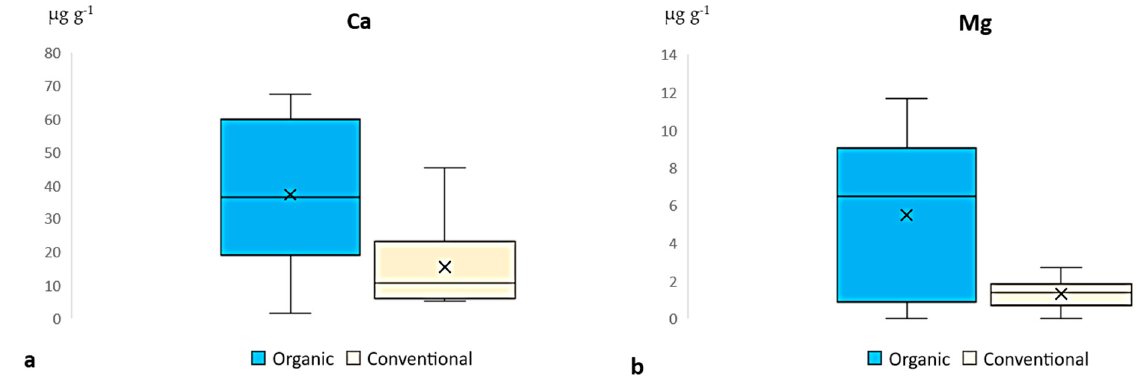
Figure 3. ( a ) Box and Whisker plot for the concentrations of calcium among organic (n = 10) and conventional (n = 10) walnut oils; ( b ) Box and Whisker plot for the concentrations of magnesium among organic (n = 10) and conventional (n = 10) walnut oils .